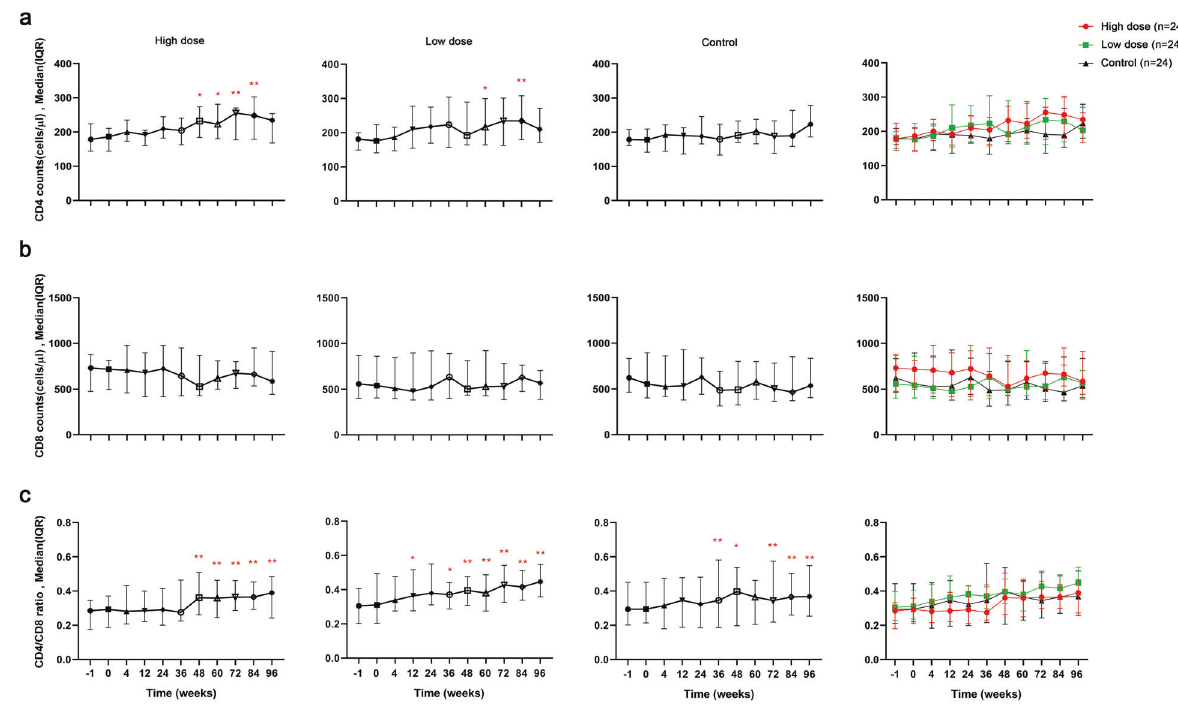
Fig. 2 Longitudinal changes of peripheral CD4 counts, CD8 counts, and CD4/CD8 ratios according to treatment group. a CD4 counts; b CD8 counts; c CD4/CD8 ratios. * P < 0.05; ** P <